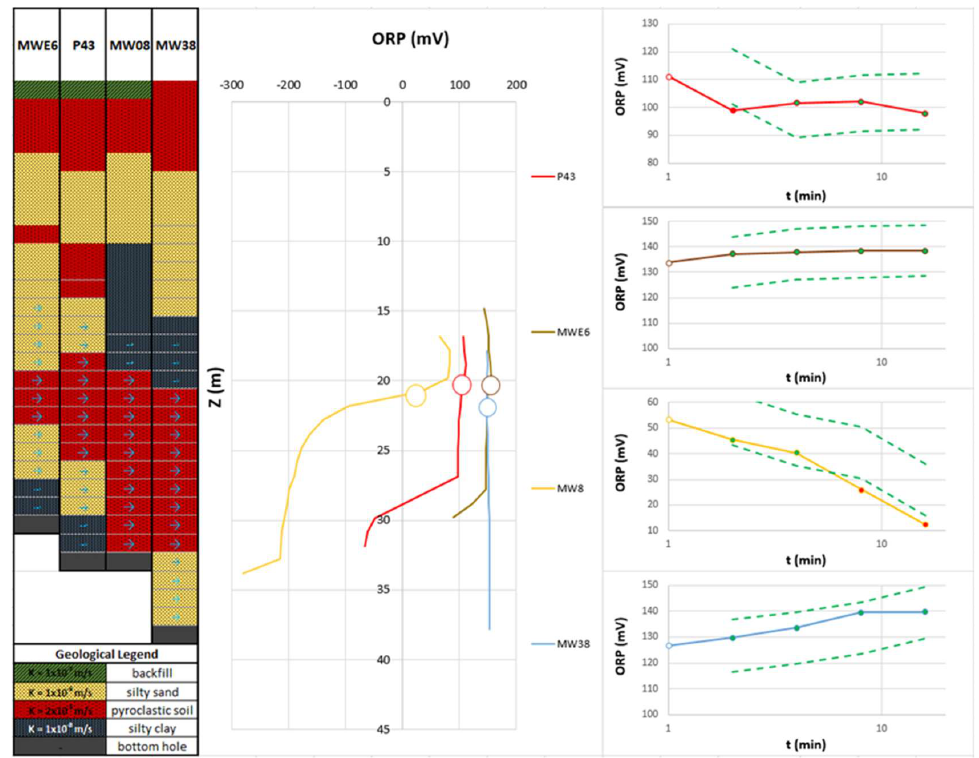
Figure 8. Layout of coupled log-purging (z-t) ORP results for high-heterogeneity well types (MWE6, P43, MW8 and MW38).